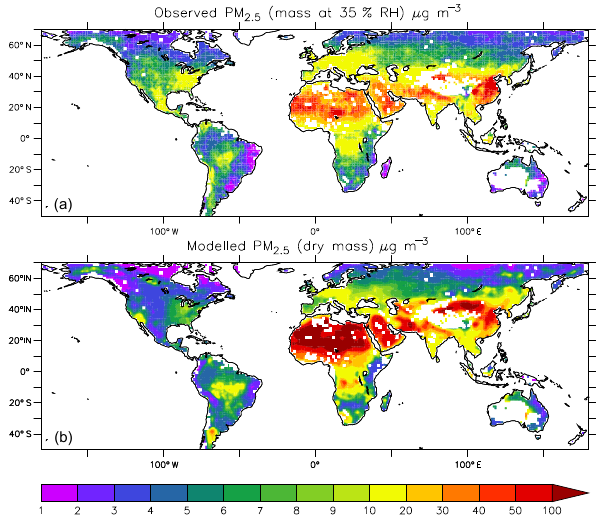
Figure 2. Scatter plot of observed and modeled yearly averaged concentrations of PM 2 . 5 (in µgm − 3 ). The colors denote the regions, i.e., blue is North America, green is Europe, purple is South Asia and red is East Asia. Black are locations outside these regions.